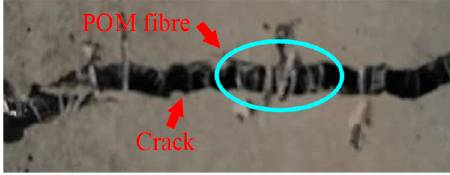
Figure 13. Bridging effect from POM fiber. Table 8. Results of compressive tests of SWSSC with different mixes.